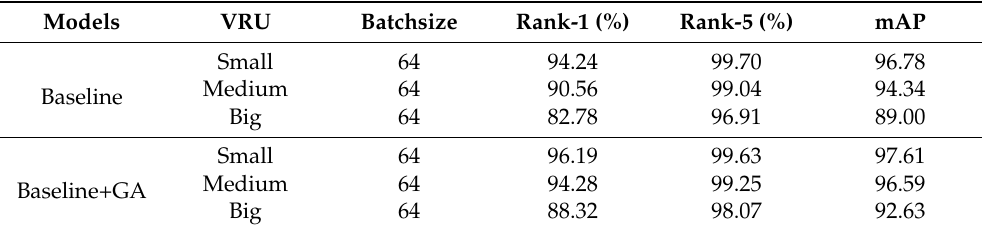
Table A2. Test results of the baseline model and the global attention model with input batch 64 on the VRU dataset.